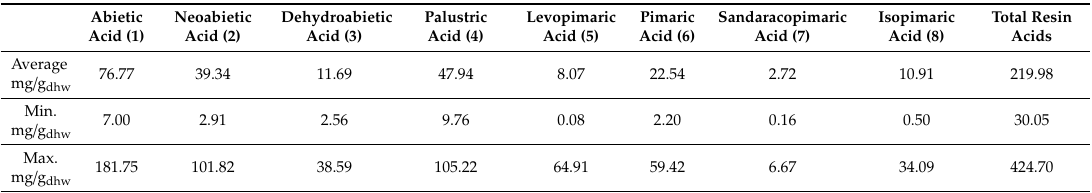
Table 4. The mean resin acid concentrations of Pinus nigra L. heartwood samples ( n = 260) as determined by quantitative 1